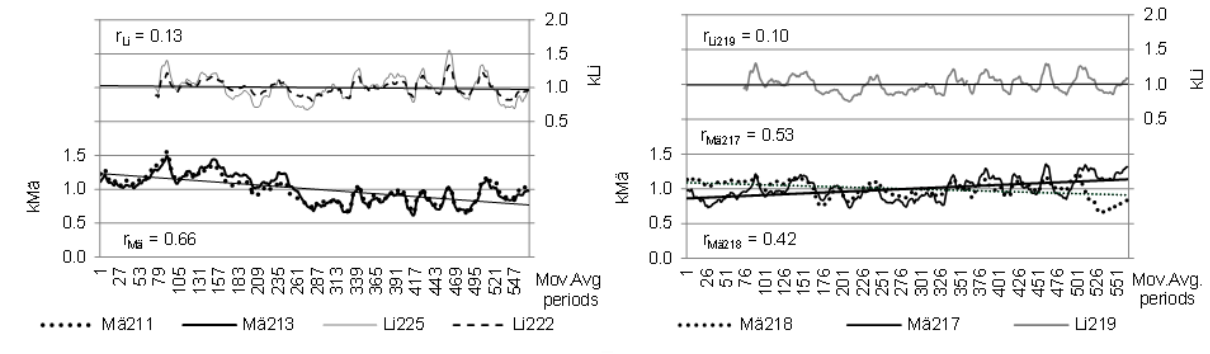
Figure 9. Linear trends of variation coefficients of groundwater levels ( k 12-month moving average (Mov.Avg.) periods over the 50 years of observations (see Equation 1). Mä211…Li222 = ridge-pool ecotopes on the Linnusaare (Li) and Männikjärve (Mä) Bogs; Mä218…Li219 = forested/treed